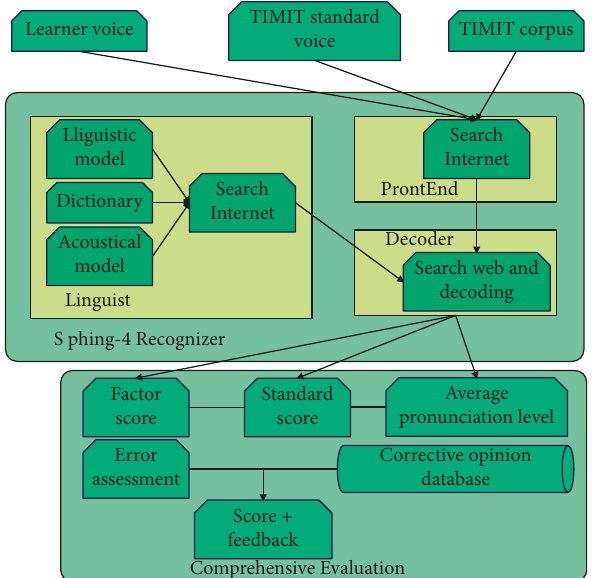
Figure 8: The automatic scoring system for spoken English.